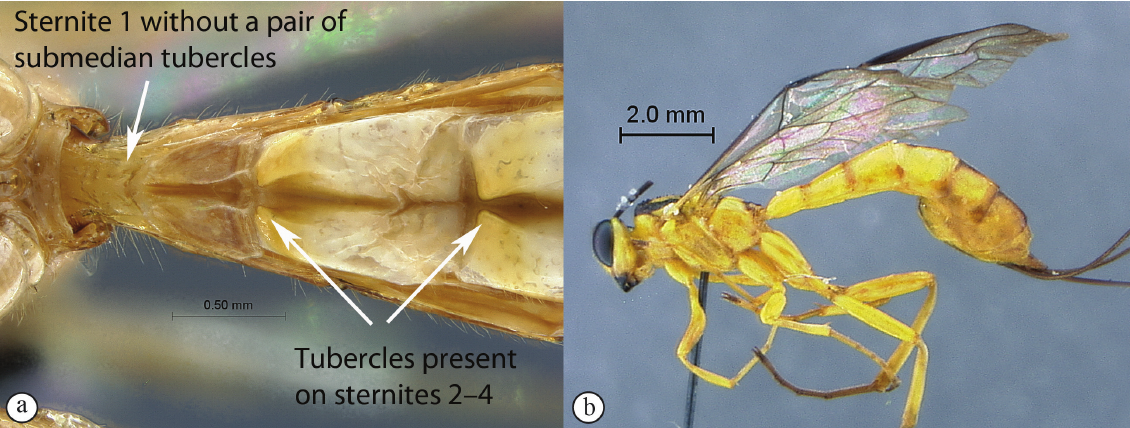
- Sternite 1 without a pair of submedian tubercles, tubercles present on sternites 2–4 only (a);